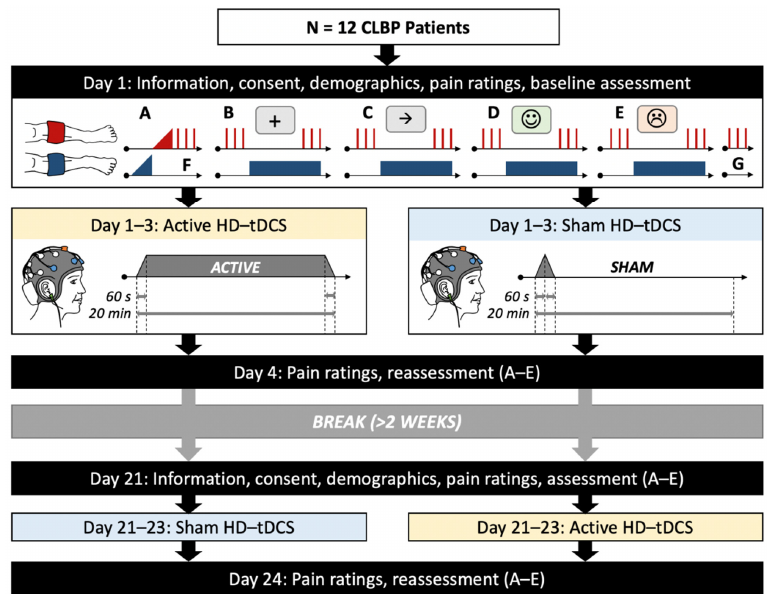
Figure 1. Schematic of chronic low back pain (CLBP) patient flow through study protocol. A: Cuff pain detection and tolerance threshold assessment, B: Conditioned pain modulation (CPM) only paradigm, C: CPM with distraction (Flanker task), D: CPM with positive affect induction, E: CPM with negative affect induction, F and G: control blocks of test stimuli. Note: order of B and C and D and E were randomized for each subject, as was assignment, to begin with active or sham high-definition transcranial direct current stimulation (HD-tDCS).